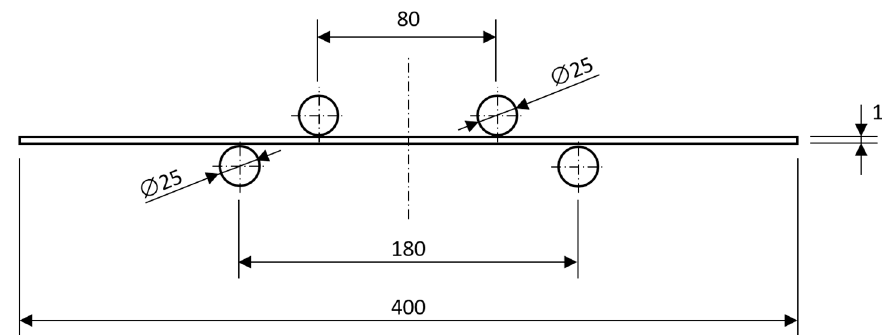
Figure 21. Four point bending setup for test scenario 1 (all dimensions in mm).